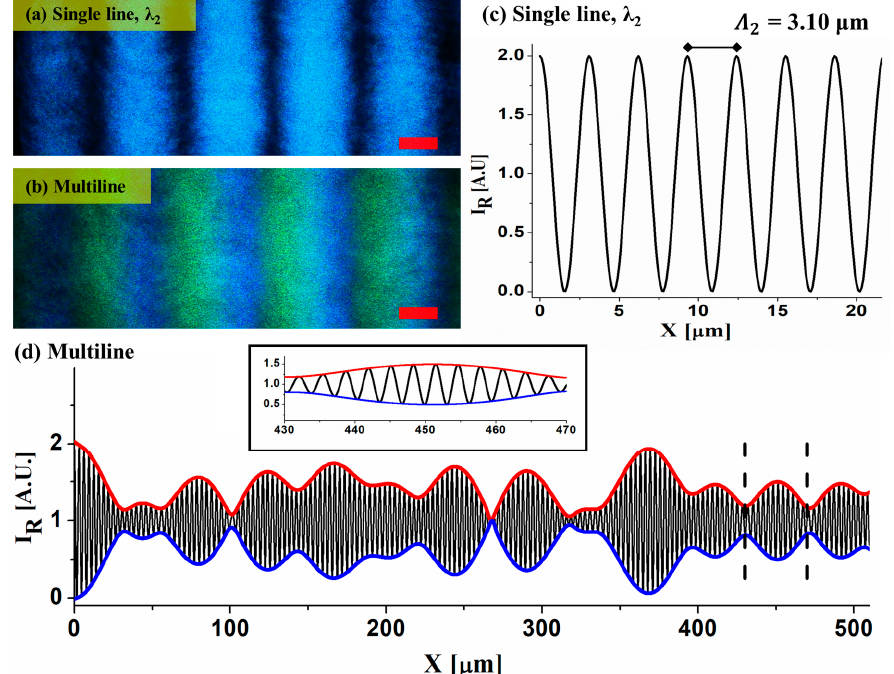
3 Figure 3. Interference fringes produced by the superposition of two, single line ( a ) or multiline ( b ), laser beams using a Michelson interferometer (the scale bar is 1 µ m). Spatial distribution of the resulting intensities, evaluated through Equation (1), in the case of single line ( c ) and multiline ( d ) interference. The black dashed lines in ( d ) delimit the interference pattern reported in the inset; The red and blue lines represent the upper and lower envelope of the curve,